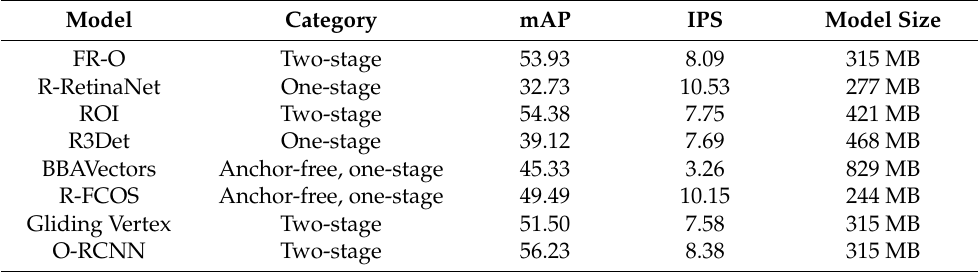
Table 4. Ship detection evaluation results for several